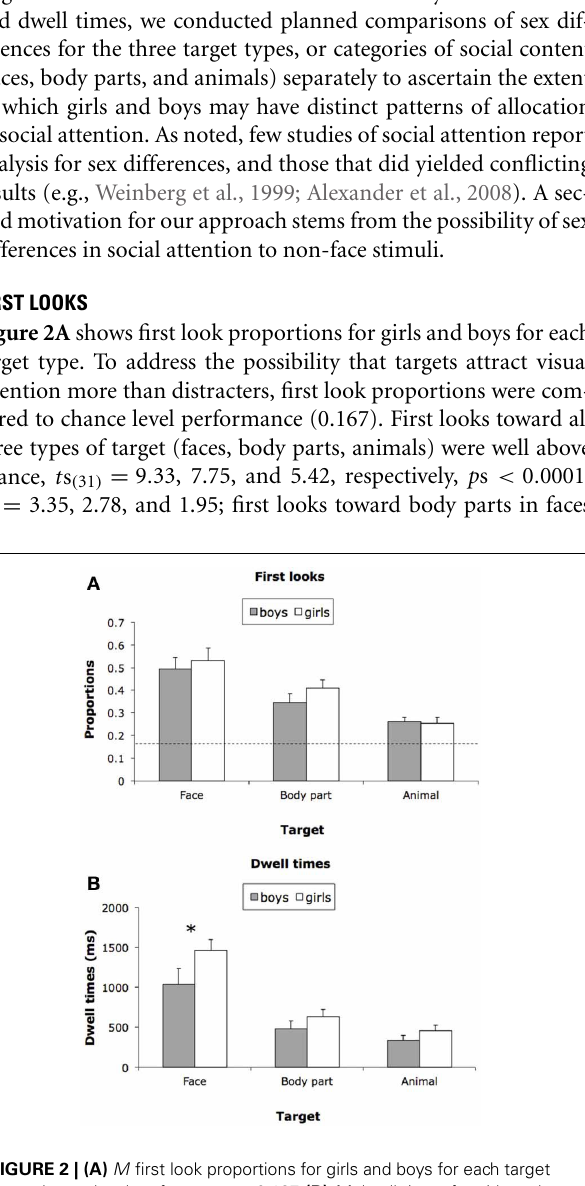
FIGURE 2 | (A) M first look proportions for girls and boys for each target type; chance level performance = 0.167. (B) M dwell times for girls and boys for each target type. ∗ p < 0 .